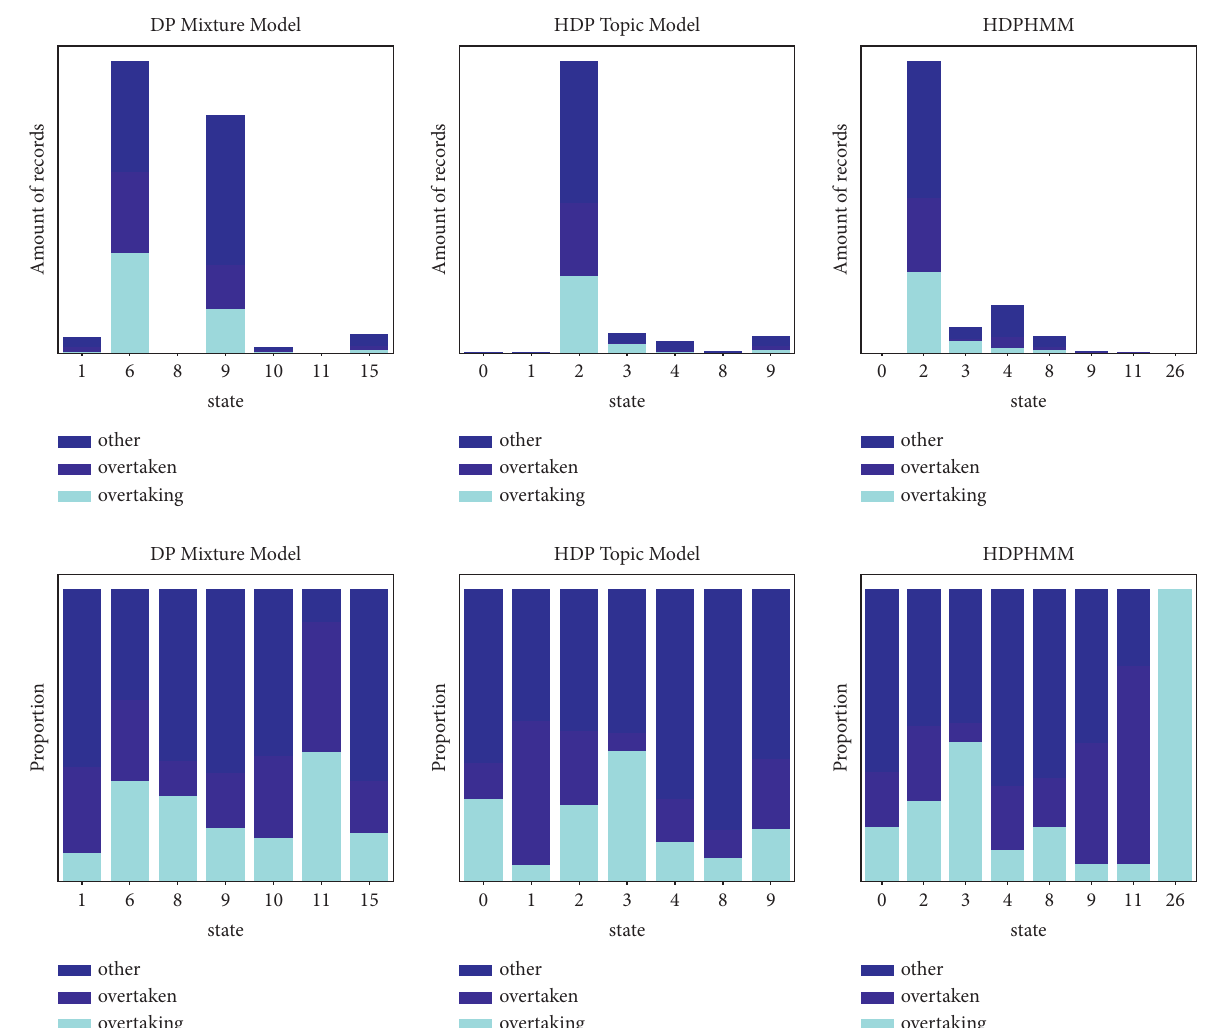
Figure 14: Compare the amounts of records in each